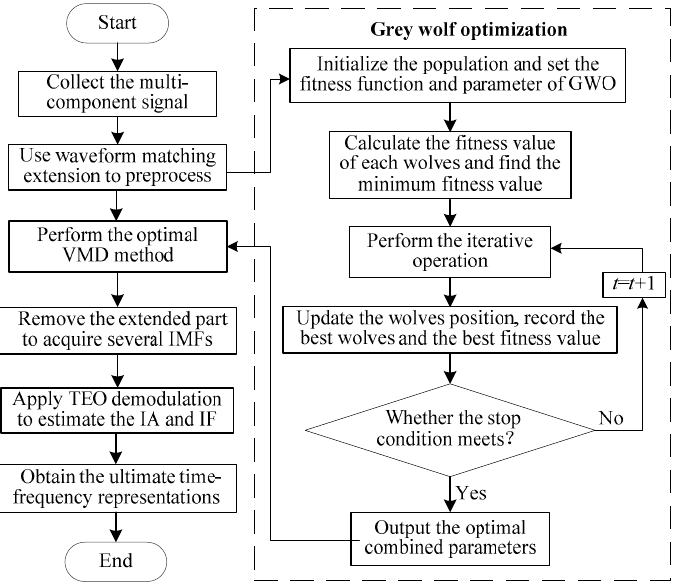
Figure 7. The flowchart of the proposed IAVMD method.